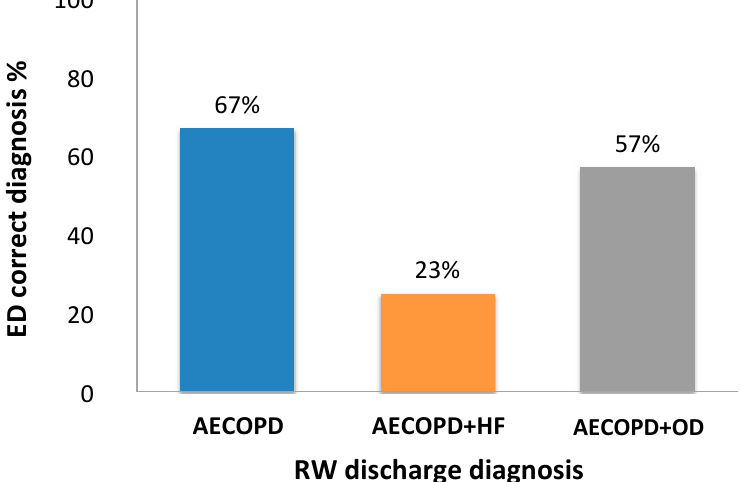
Figure 1. Comparison of Emergency Department (ED) and Respiratory Ward (RW) diagnosis. Percentage of ED diagnosis that coincided with the RW diagnosis of acute exacerbation of COPD (AECOPD), acute exacerbation of COPD and heart failure (AECOPD and HF) and diagnosis other than AECOPD or AECOPD and HF (AECOPD and OD).